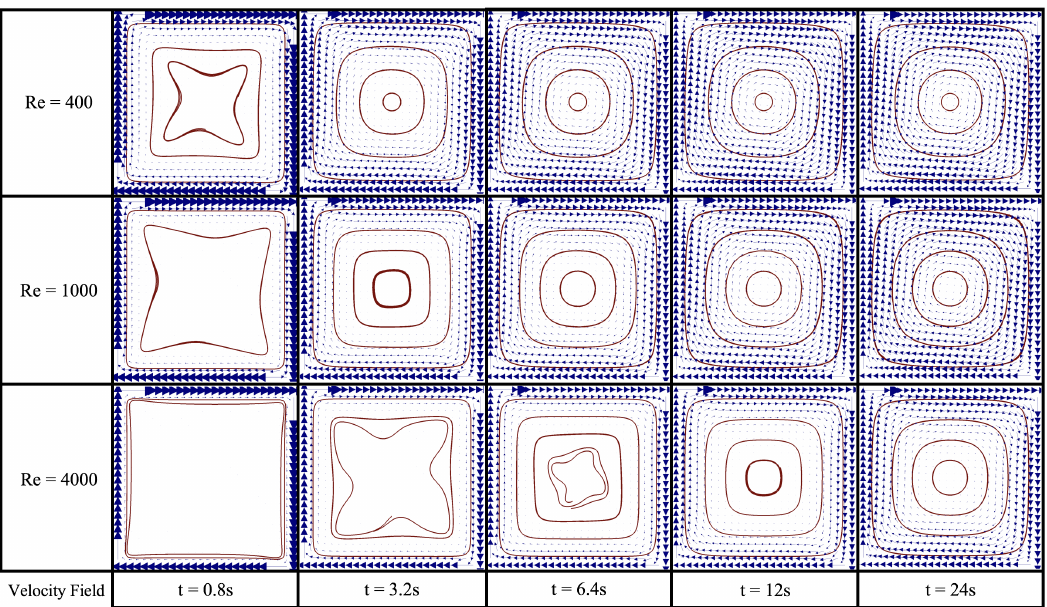
Figure 26. Snapshots showing the velocity field’s evolution between cases of Re = 400,1000, and 4000. Streamlines of the velocity field are also illustrated.